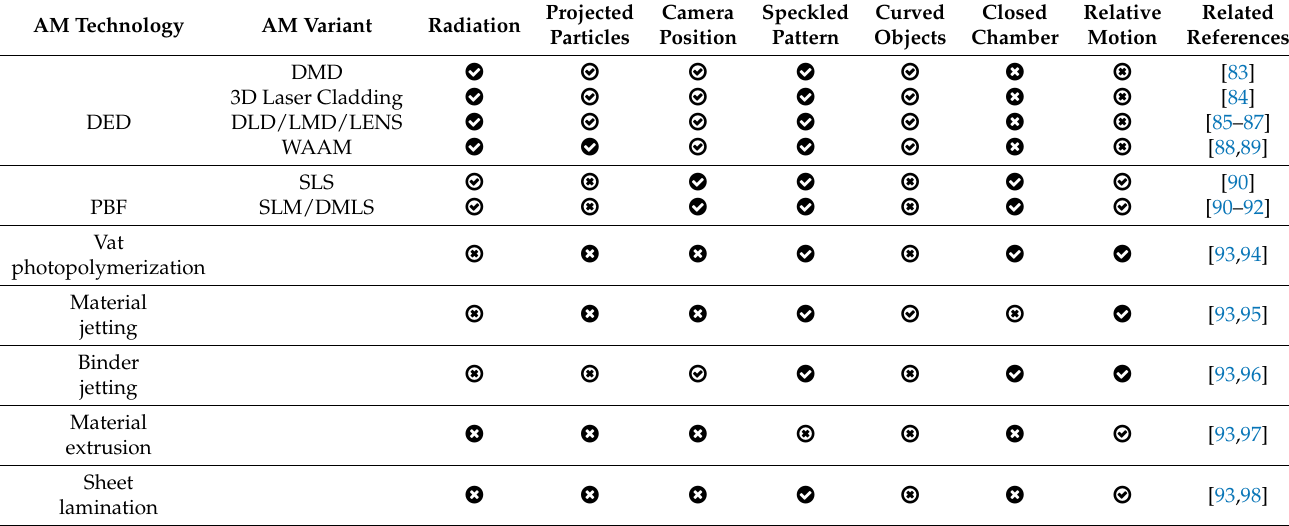
Table 1. Summary of main difficulties in applying DIC to the different AM variants.